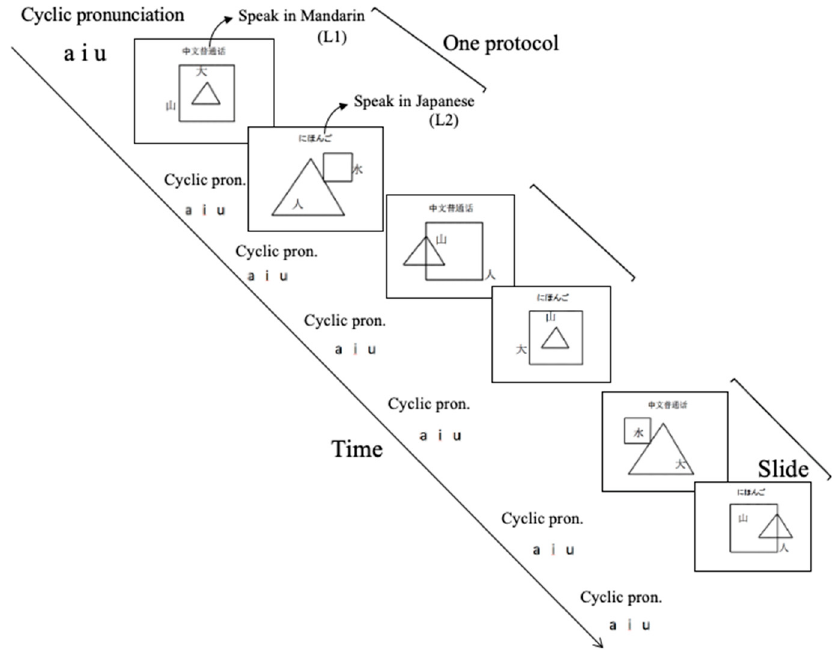
Figure 1. Speaking task slide schedule.